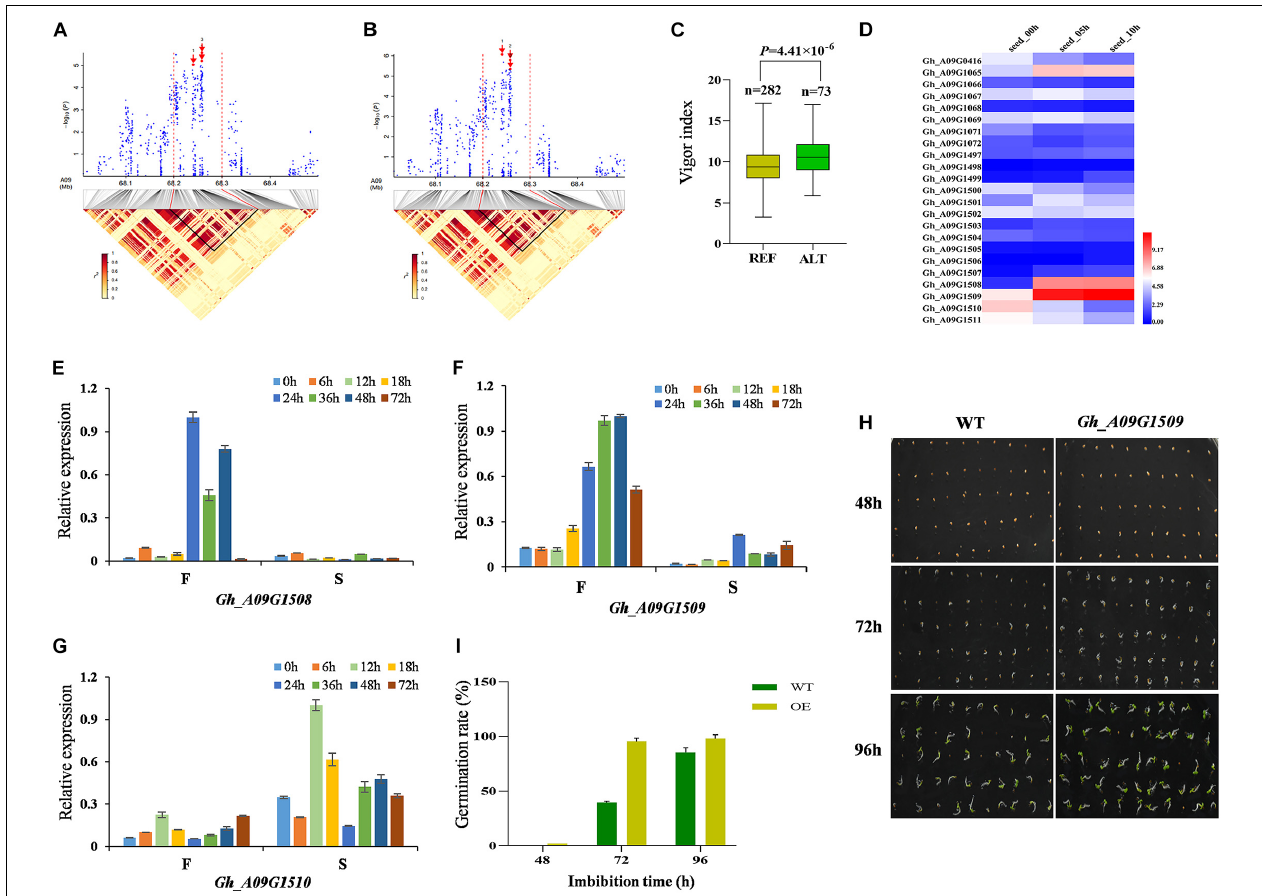
FIGURE 4 | Identification and expression analysis of candidate genes related to seed germination on chromosome A09. (A) Local Manhattan plot (top) for GRA and LD heat map (bottom) surrounding the peak region (68.0–68.5 Mb) on A09, and red arrow 1, 2, and 3 indicate the position of associated SNP A09:68240653, A09:68257990, and A09:68258389, respectively. (B) Local Manhattan plot (top) for VI and LD heat map (bottom) surrounding the peak region (68.0–68.5 Mb) on A09. (C) Box plots for VI, based on the significantly associated SNP on A09, n indicates the number of accessions with the same genotype. REF, the reference GG; ALT, the alternate GA. Significant difference was analyzed with a two-tailed t -test. (D) Heat map of the candidate gene expression of chromosome A09 at different cotton seed imbibition stage based on the FPKM value. Red indicates high expression, and blue indicates low expression. (E–G) Expression analysis of three candidate genes ( Gh_A09G1508 , Gh_A09G1509 , and Gh_A09G1510 ) between F (cotton variety with fast germination: Jinmian2) and S (cotton variety with slow germination: Qunkemian) via qRT-PCR at 0, 6, 12, 24, 36, 48, 60, and 72 h, Ghhistone3b was used as an internal control. The data were normalized to the maximum value. The error bars indicate ± SE; n = 3 independent biological replicates. (H) Germination phenotype of Gh_A09G1509 overexpressing lines and the WT at the seed germinating stage 48, 72, and 96 h in tobacco. WT, wild-type plants. (I) GRA of overexpressing lines and the WT in